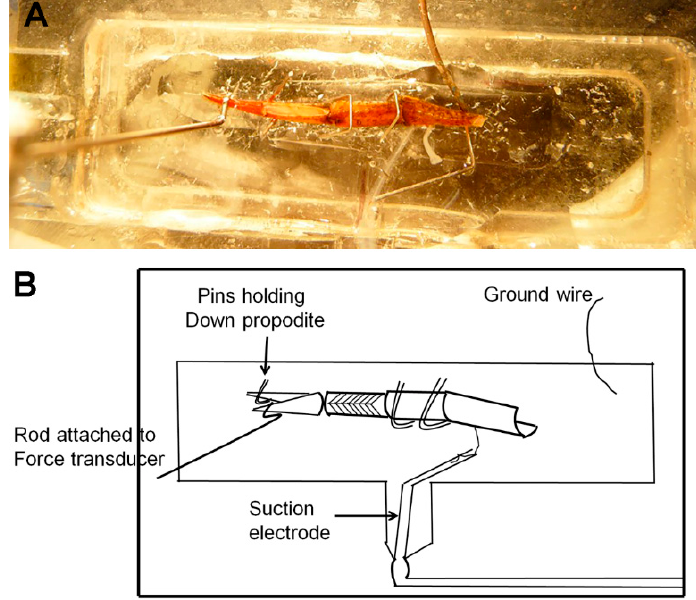
Figure 2. Recording chamber showing pinning of preparation and suction electrode: ( A ) The photograph shows a dorsally dissected preparation pinned in the recording dish with the force transducer pin resting on the dactylopodite. The suction electrode holding the excitatory nerve can be seen in the bottom center of the dish, and the inhibitory nerve is floating free. ( B ) A diagram detailing the recording chamber setup specifically showing how the preparation is pinned between the dactylopodite and ventral propodite.